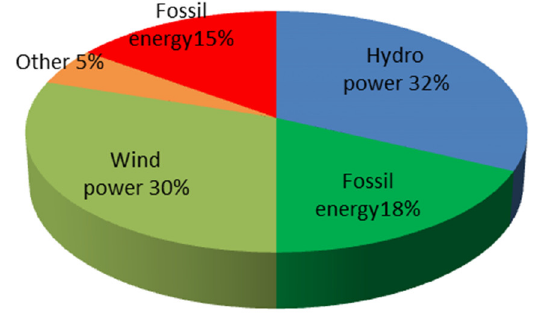
Figure 8. 2060 energy consumption forecast.